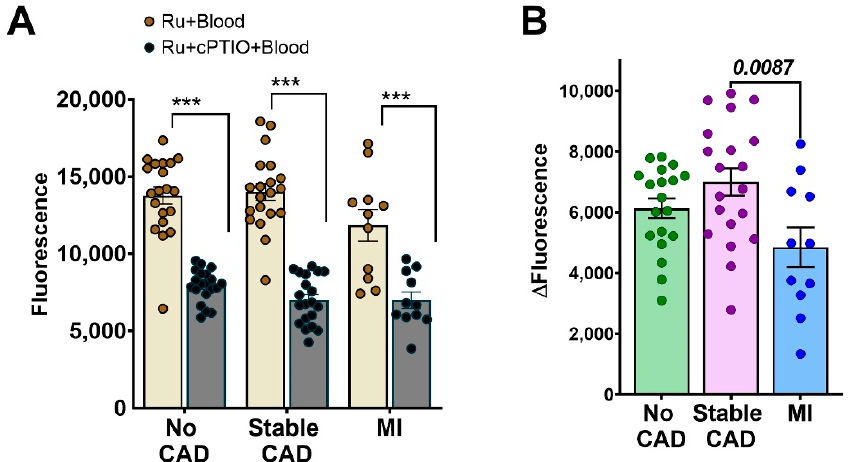
Figure 7. Ru-NO in blood samples from patients with coronary artery disease. Plasma Ru-NO fluorescence was quantified using spectrophotometry in peripheral arterial blood samples from patients presenting for an angiogram that were divided into groups of either (1) no or minor coronary artery disease (CAD, <20% narrowing of the vessels, n = 19), (2) stable CAD (<20% narrowing of the vessels without myocardial infarction, n = 20), or (3) with myocardial infarction (MI, >70% narrowing of the vessels with myocardial infarction, n = 11). ( A ) Plasma fluorescence from blood samples added with Ru-NO or Ru-NO + cPTIO (NO scavenger). ( B ) The Δ fluorescence (Ru-NO–Ru-NO + cPTIO) NO specific signal from patient blood samples. Mean ± SEM, *** p < 0.01 using one-way ANOVA with Tukey post-hoc test for multiple comparisons across different groups.